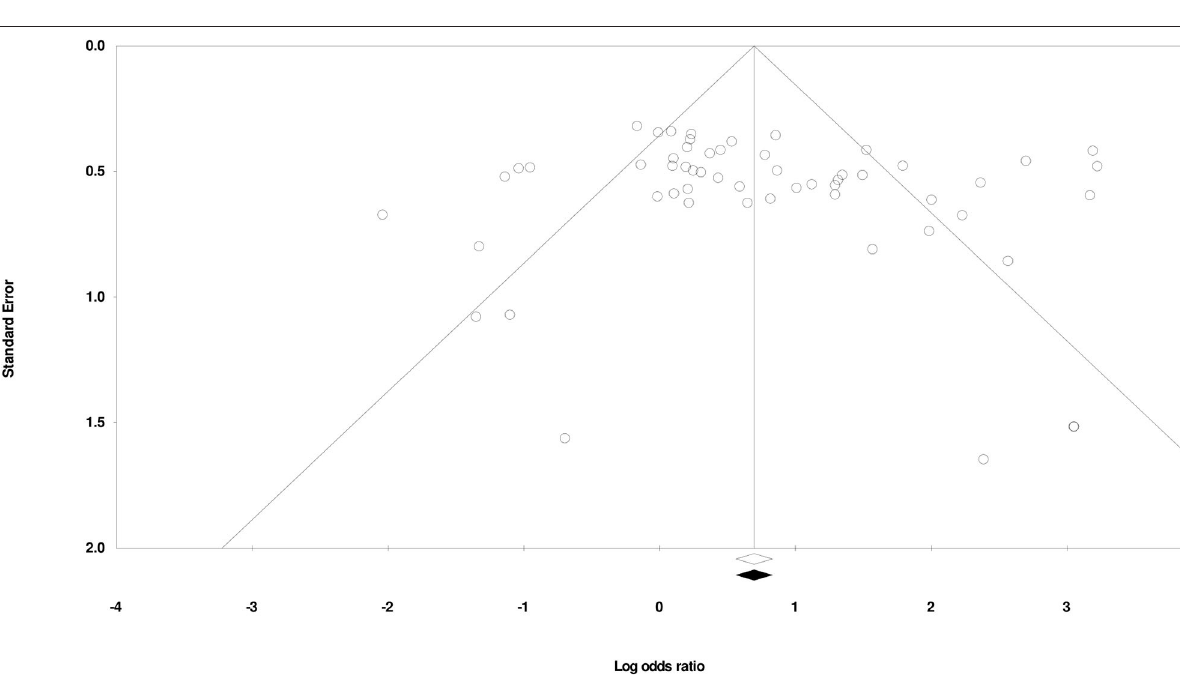
FIGURE 3 | Publication bias by Duval and Tweedy’s trim and fill